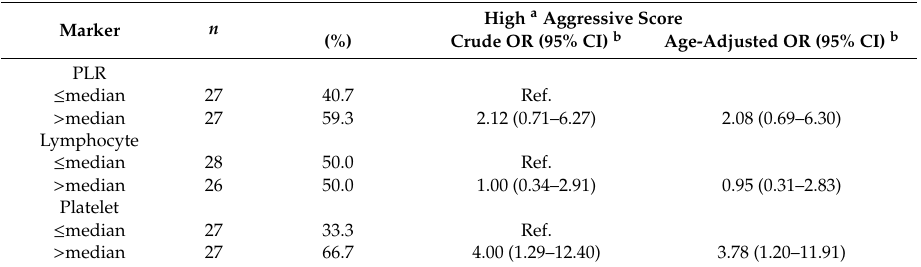
Table 2. Association between markers of systemic inflammation and aggressive score.